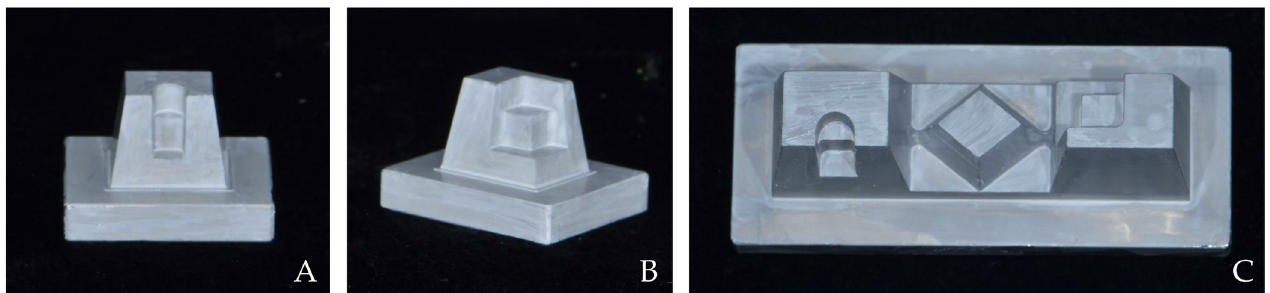
Fig 1. Specially designed reference models. A—inlay model; B—onlay model; C—bridge model.